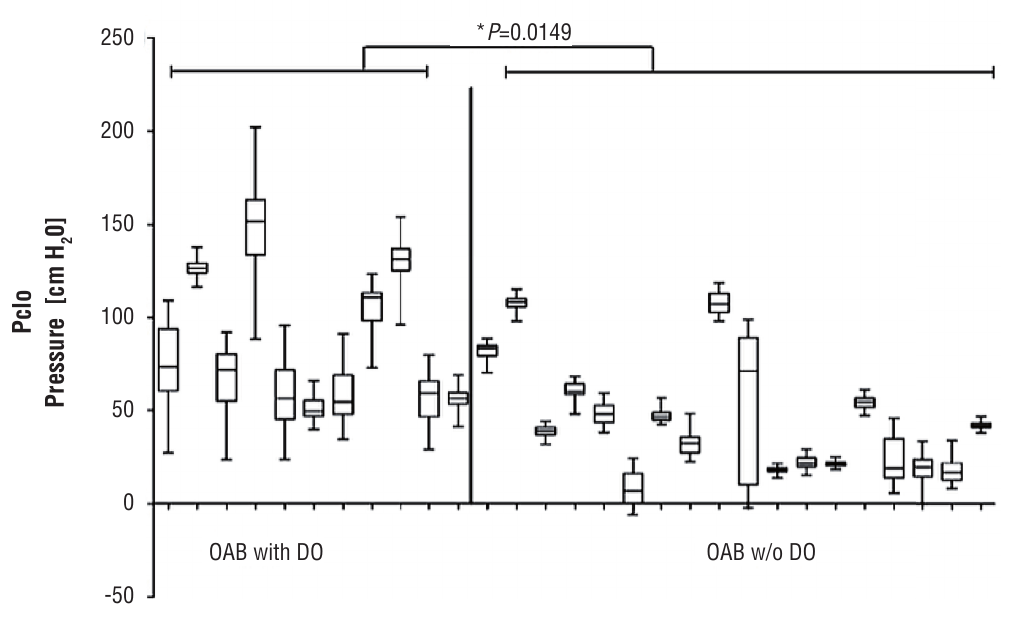
Figure 3 - Urethral Pressure in OAB patients with (left) or without (right) DO, single asterisk displays signifi cance difference between the two groups determined with two-tailed t-test.